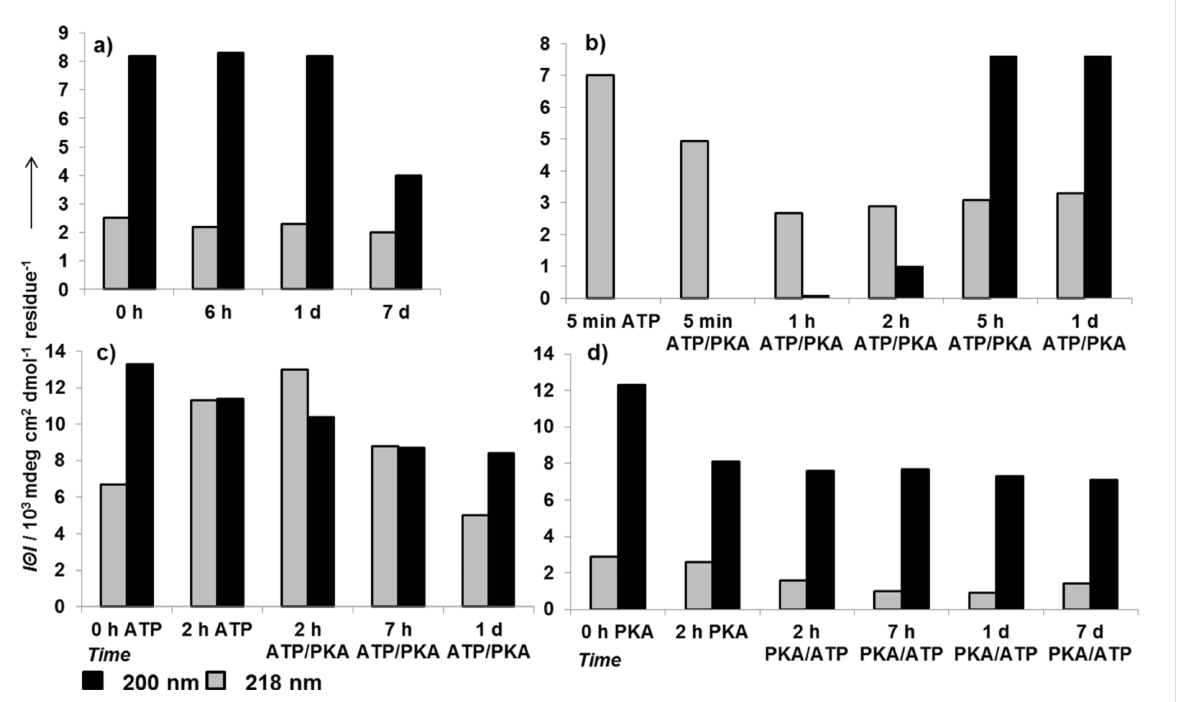
Figure 4: a) Enzymatic phosphorylation of 15 µM KFM6 in time-dependent CD-minimum plots. Addition of both 200 µM ATP and 5000 U PKA at time of dissolution of peptide; b) ATP-induced β -sheet formation, reversed by the addition of PKA after five minutes of incubation; c) the influence of ATP during the first two hours of conformational change and effect of two hours delayed phosphorylation; and d) the inverse experiment with